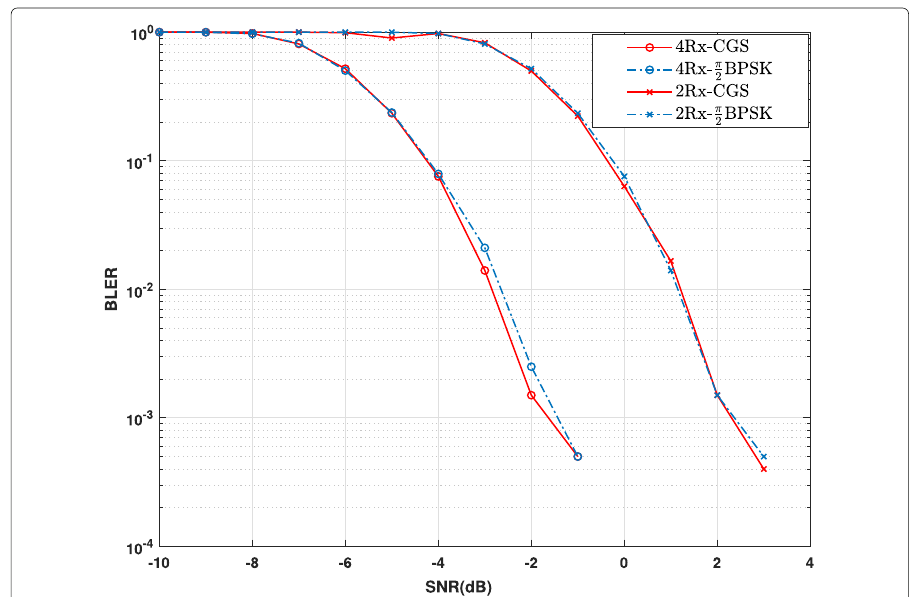
Fig. 18 BLER comparison of length-24 CGS and π/ 2-BPSK DMRS sequences